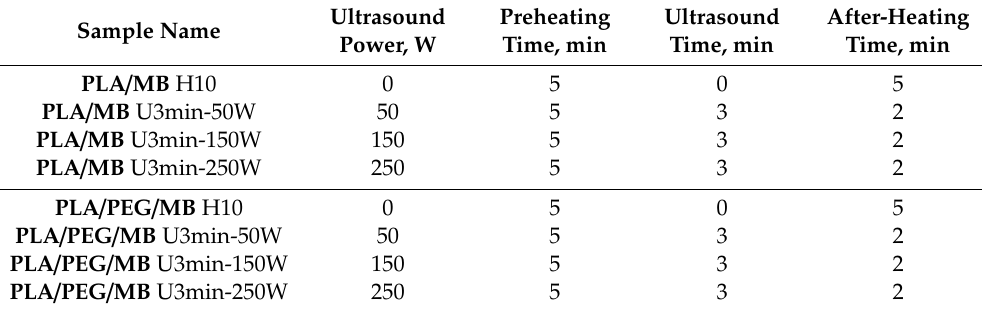
Table 2. Processing parameters for PLA / MB (100 / 1) and PLA / PEG / MB(65 / 35 /